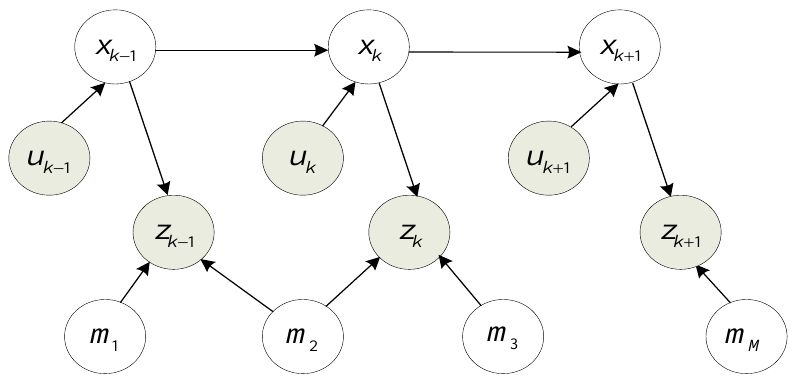
Figure 6. The SLAM graphical model.